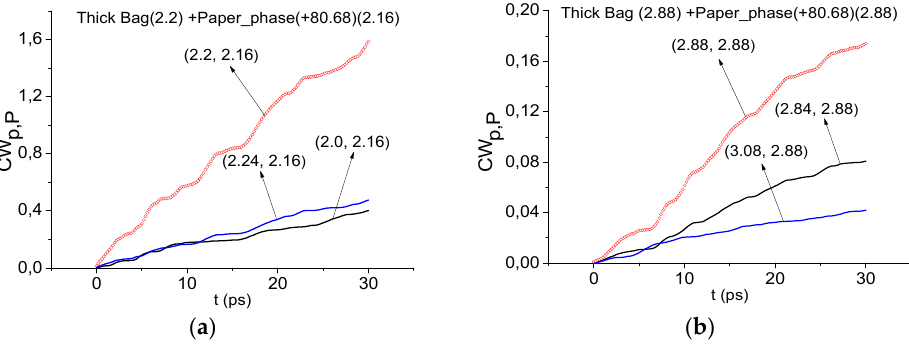
Figure 9. Time-dependent integral characteristics CW p,P ( t n ) detection frequencies ν = 2.2 THz ( a ); 2.88 THz ( b ) for the Thick Bag signal and Paper_Phase(+80.68) as a standard signal.